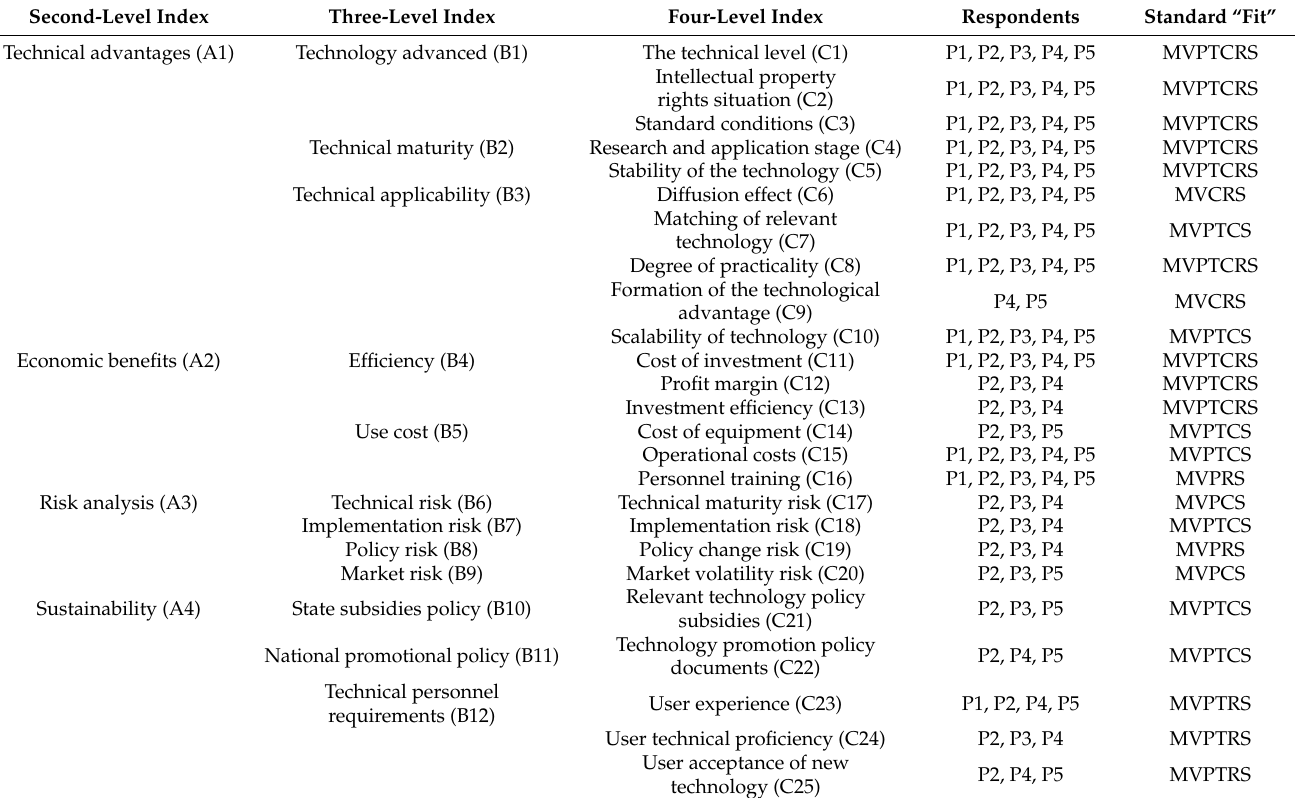
Table 4. Soil water sensing technology index system